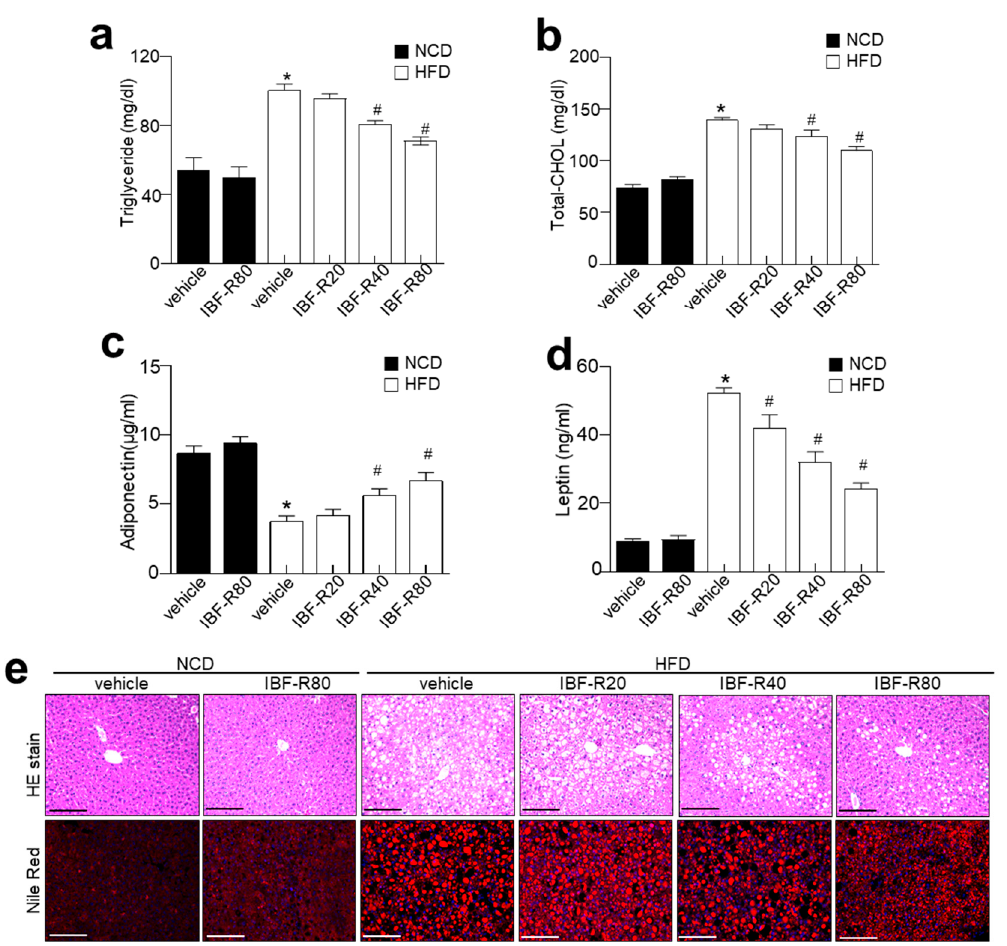
Figure 2. Influence of IBF-R serum biochemicals profile and lipid accumulation. Levels of triglyceride ( a ), total cholesterol ( b ), adiponectin ( c ), and leptin ( d ). ( e ) Representative images of liver sections stained with H&E (upper) and Nile Red stain (lower). Scale bars = 50 µm. Data are shown as mean ± SEM ( n = 10, * p < 0.05 vs. NCD + vehicle, # p < 0.05 vs. HFD + vehicle).